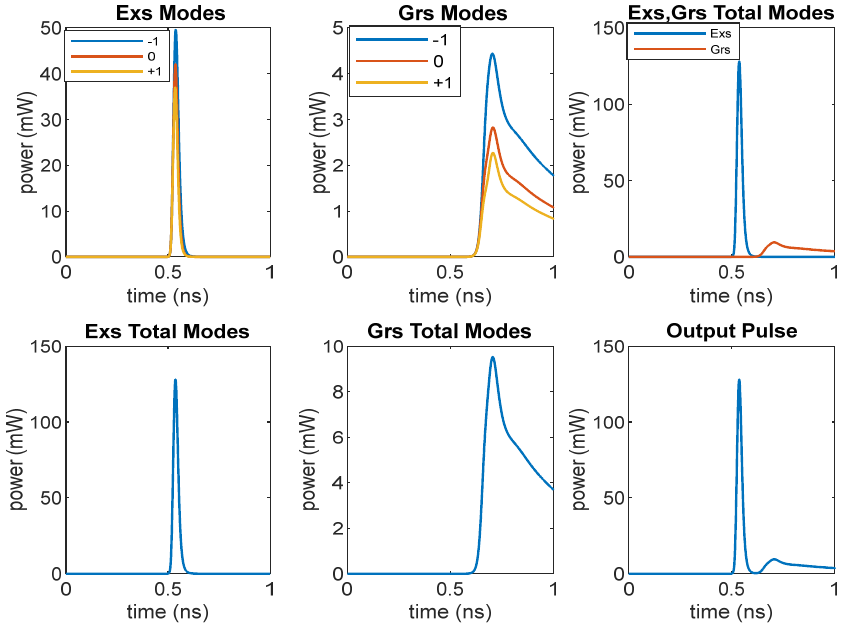
Figure 13. Output pulse under the illumination of an EOGB of 20 mW for I rf = 12 mA.